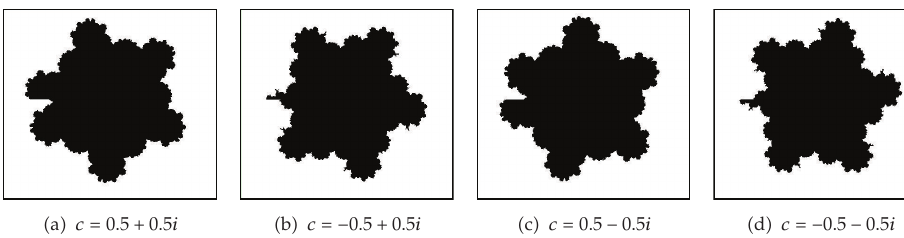
Figure 4: The generalized J sets without any perturbation when α (cid:6) 5 . 5, θ ∈ (cid:7) − π,π (cid:4)